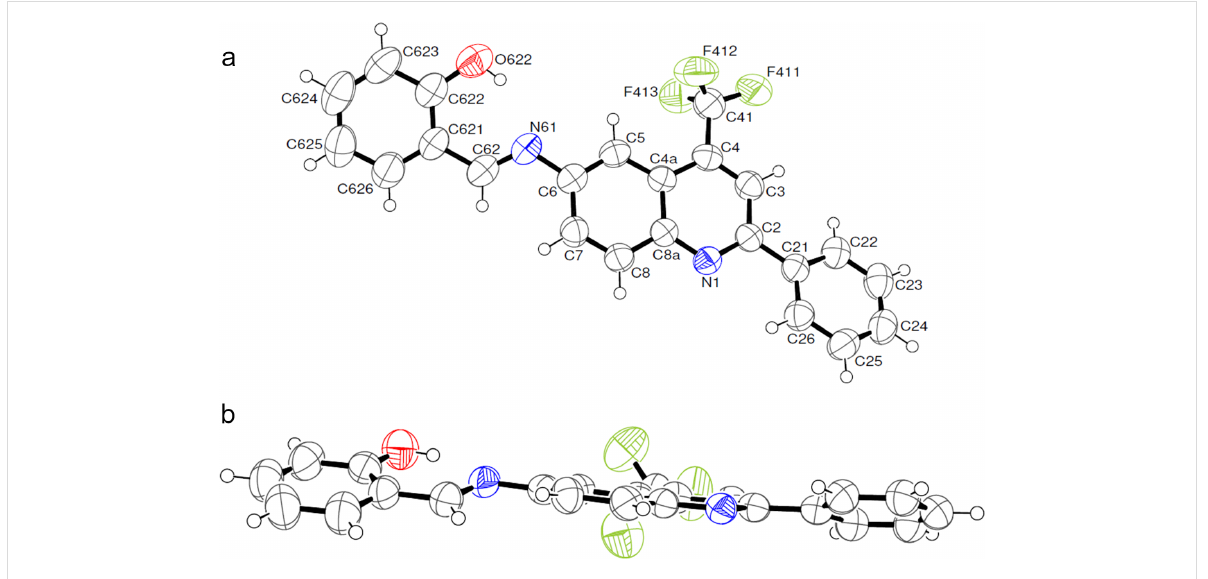
Figure 2: ORTEP diagram of the crystal structure of ( E )-2-(((2-phenyl-4-(trifluoromethyl)quinolin-6-yl)imino)methyl)phenol ( 3ba , CCDC 2036933). (a) Displacement ellipsoids are drawn at the 50% probability level, and circles with arbitrary radius represent the hydrogen atoms; (b) side view showing coplanarity of the same system.